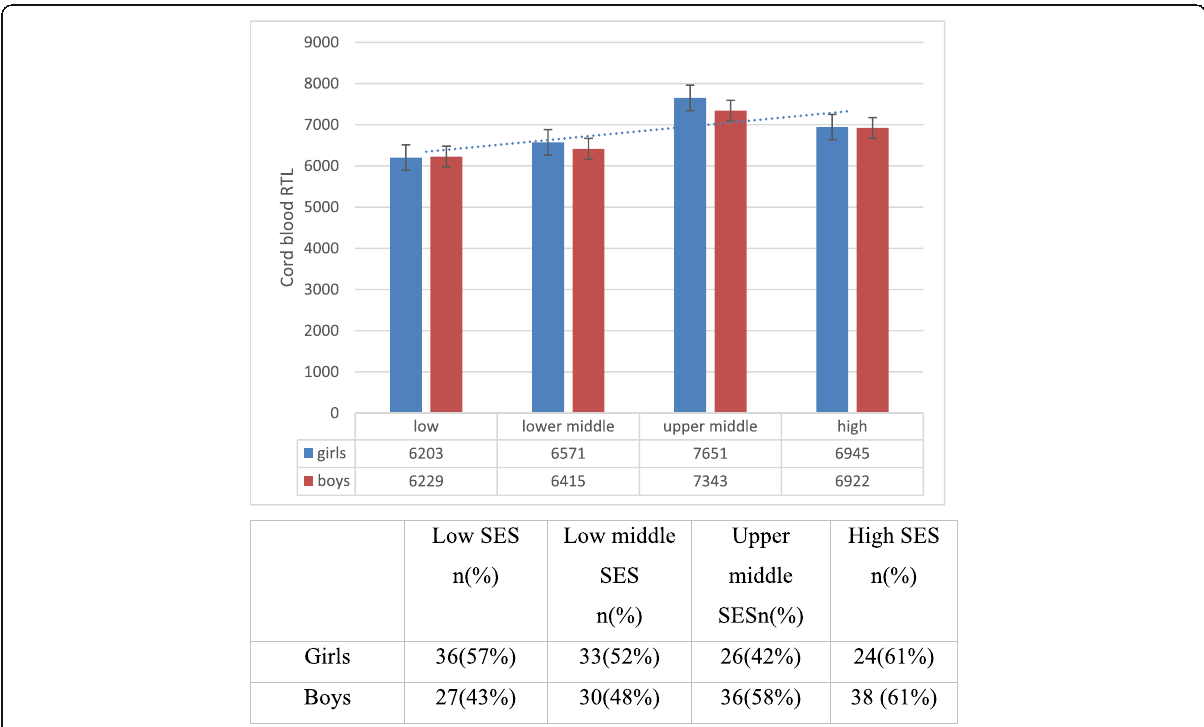
Fig. 3 Frequency of gender among different socioeconomic status by the Mann-Whitney test. Trend line highlighted the gradual increase in girl ’ s telomere length from low SES to high